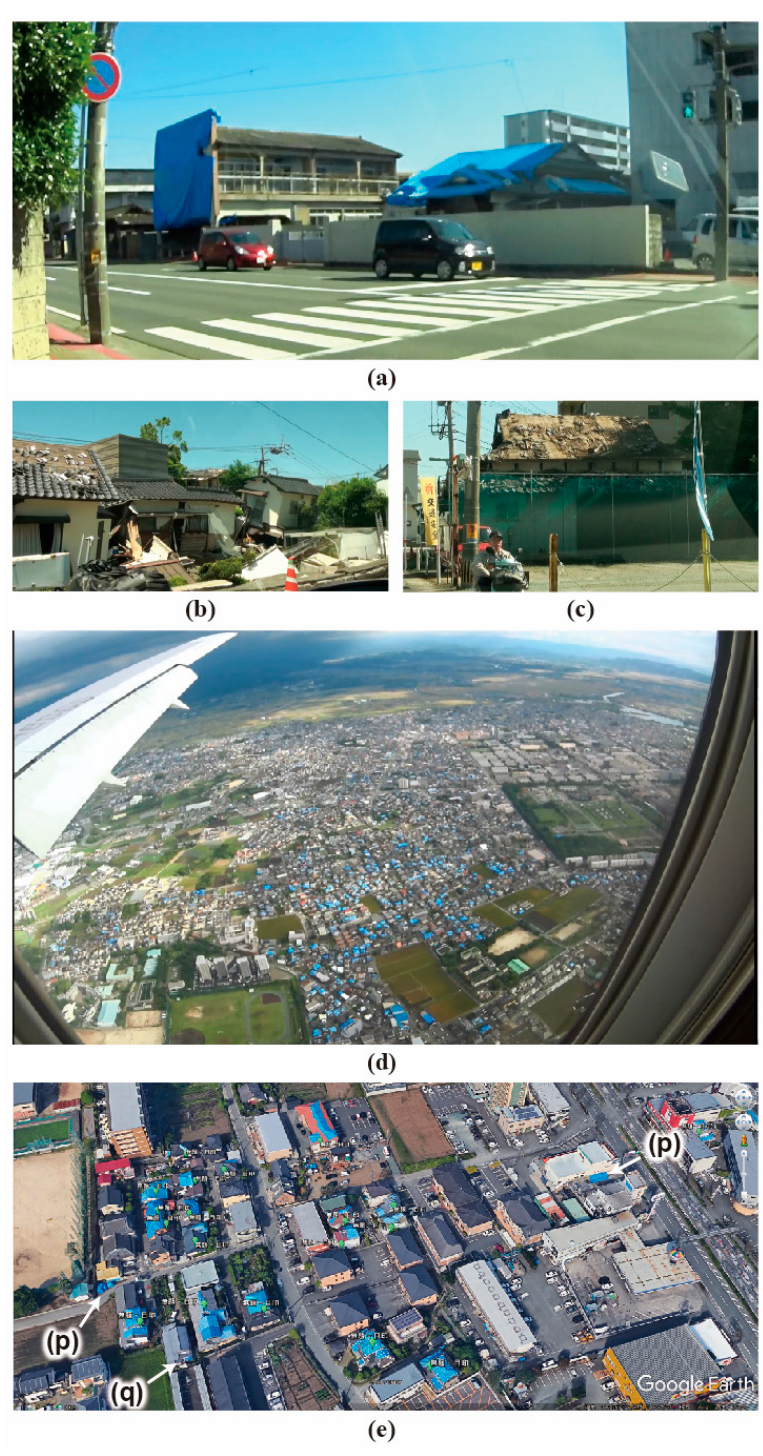
Figure 2. Situations of post-earthquake Kumamoto city. ( a ) Damaged buildings are covered with plastic sheets, whereas ( b ) catastrophic and ( c ) older buildings are neglected. ( d ) Roofs covered with plastic sheets are identifiable from an airplane and ( e ) in Google Earth 3D models. (p) Other external materials and (q) lined walls are also covered with the sheet.